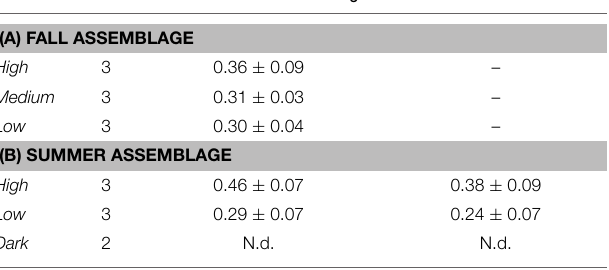
TABLE 1 | Mean specific growth rates, µ , and standard errors of the means ( σ M ), of the (A) late fall and (B) late summer plankton